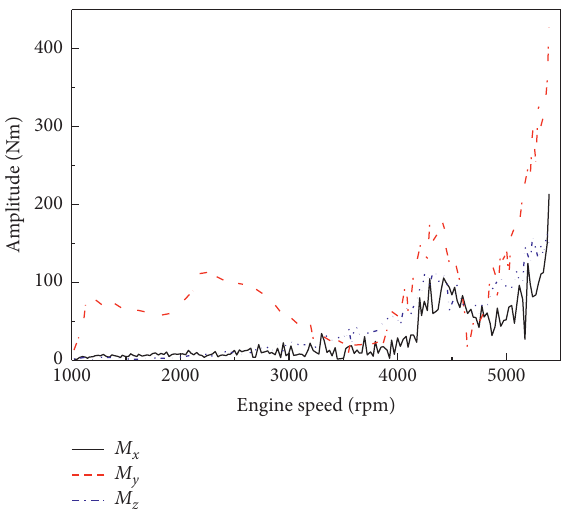
Figure 9: Excitation forces acting on the midpoint of crankshaft spindle